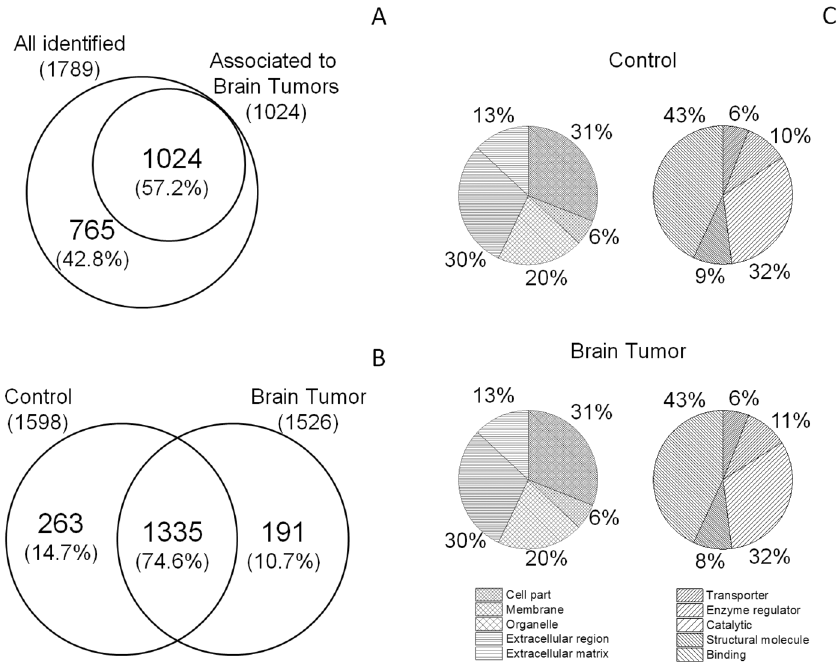
Figure 1. Venn diagram and pie chart of the identified proteins. Venn diagram of proteins previously described as associated to brain tumors ( A ) and total proteins identified in CSF from EVD of control and brain tumor samples ( B ). Both diagrams show common and exclusive proteins. Numbers represent the distinct proteins. ( C ) Pie chart of the enrichment of gene ontology annotation terms in the two